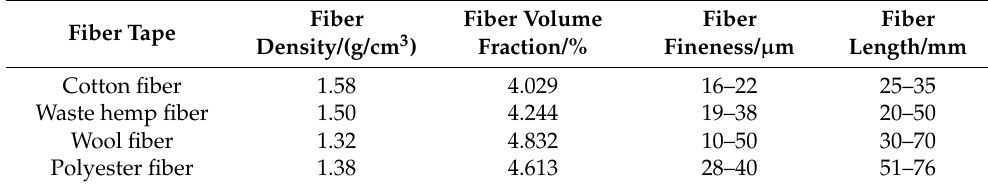
Table 5. Related parameters of measured fiber.